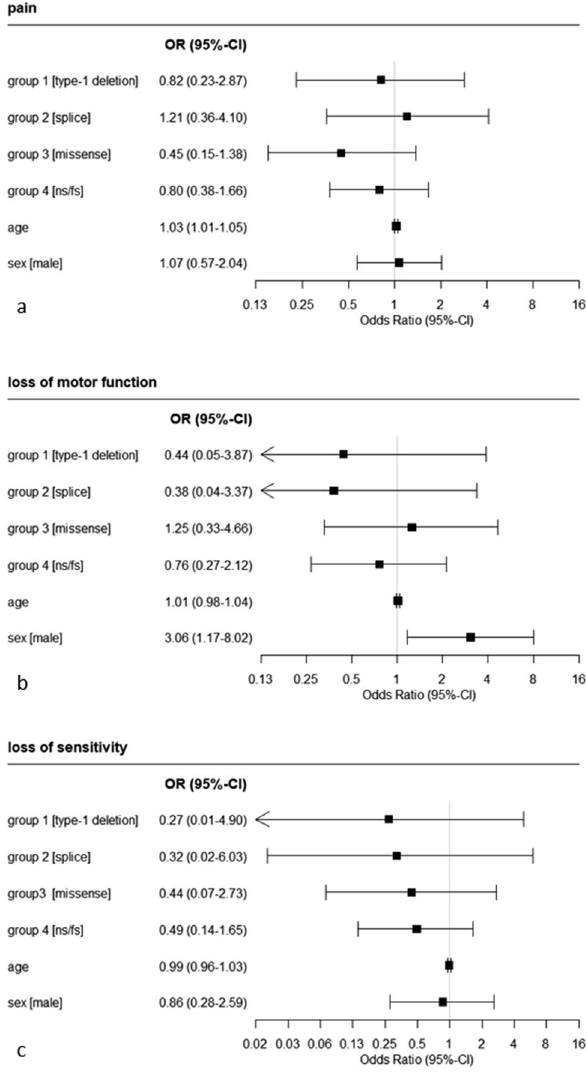
Figure 4. Results of logistic regression analysis on the association of clinical symptoms backpain ( a ), loss of motor function ( b ) and loss of sensitivity ( c ) with type of mutation of the NF1 gene, age and